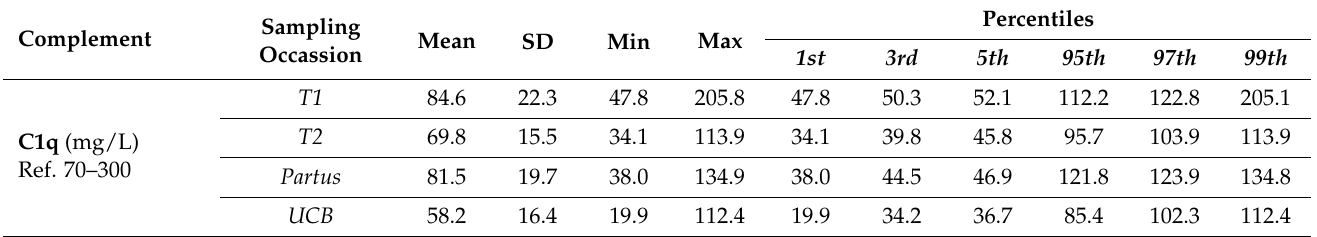
Table 2. Complement protein levels in maternal plasma and umbilical cord